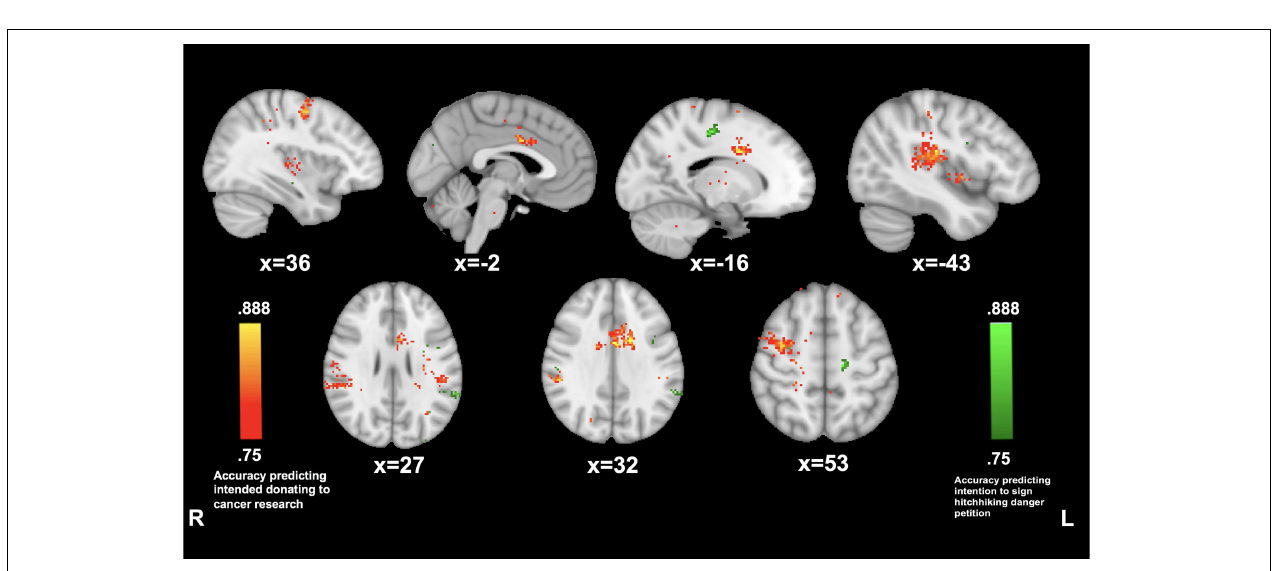
FIGURE 6 | Posterior medial cortex connectivity predictive of prosocial intention during The Living Room . MVPA searchlights showing above chance classification of PMC connectivity maps for high vs. low prosocial intention for related (red) vs. unrelated (green) issues during The Living Room.